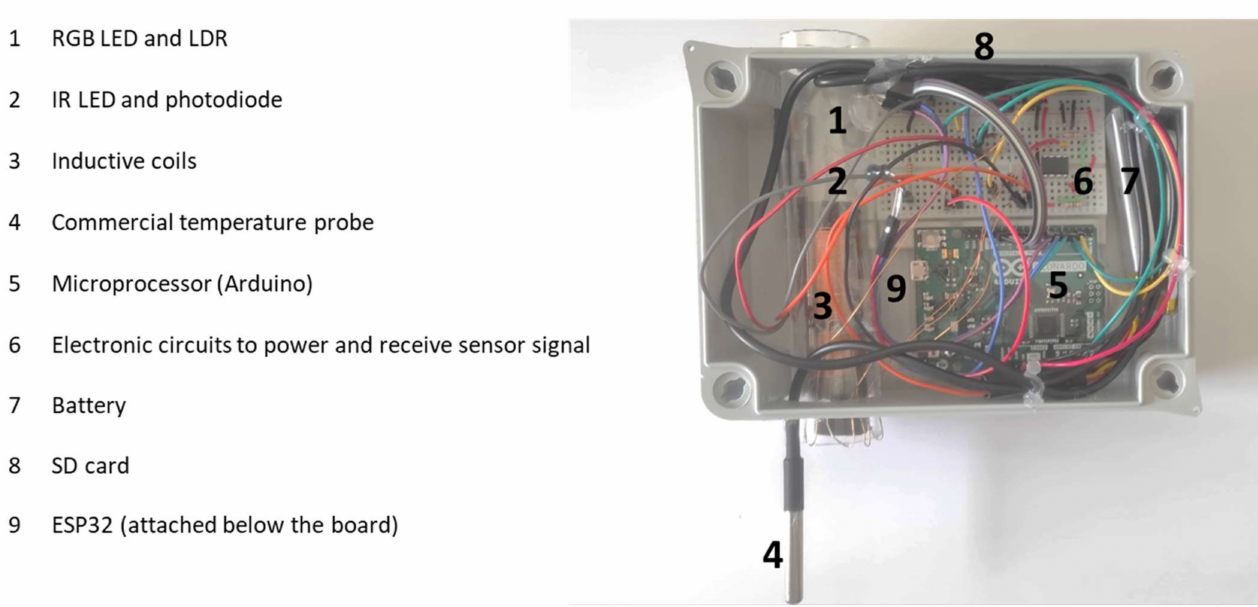
Figure 6. Real image of our